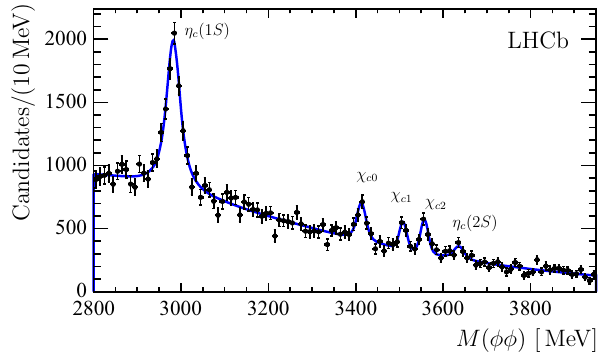
Fig. 4 Distribution of the invariant mass of φφ combinations. The number of candidates in each bin is obtained from the corresponding 2D fit. The peaks corresponding to the cc resonances are marked on the plot. The signal yields are given in Table 1 Table 1 Signal yields with statistical uncertainties of the fit to the spectrum of the φφ